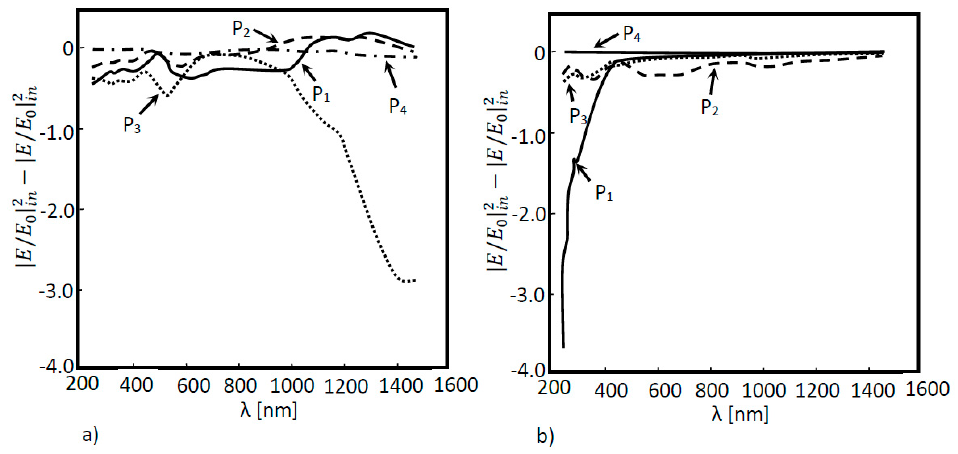
Figure 14. Absorption curves of the simulated 3D CIGS structure: ( a ) without the inclusion of a nanoantenna; ( b ) with the inclusion of a nanoantenna.